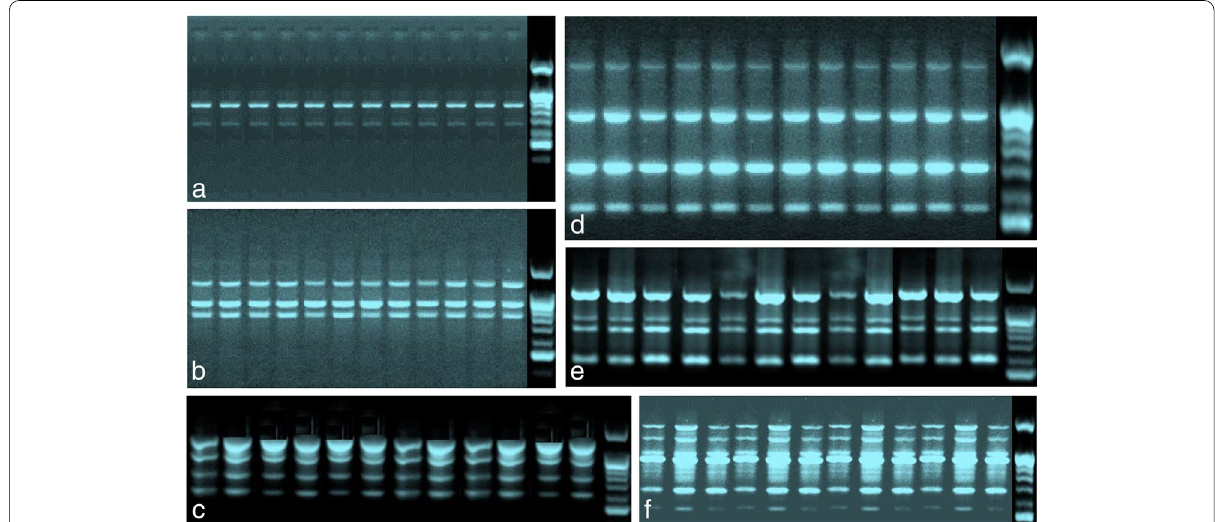
Fig. 3 Polymerase chain reaction (PCR) amplification products were obtained with random amplified polymorphic DNA (RAPD) primers. M for the mother plant, 1–11 represent the micropropagated hardened plants, and MA for the DNA ladder. a PCR amplification with RAPD primer